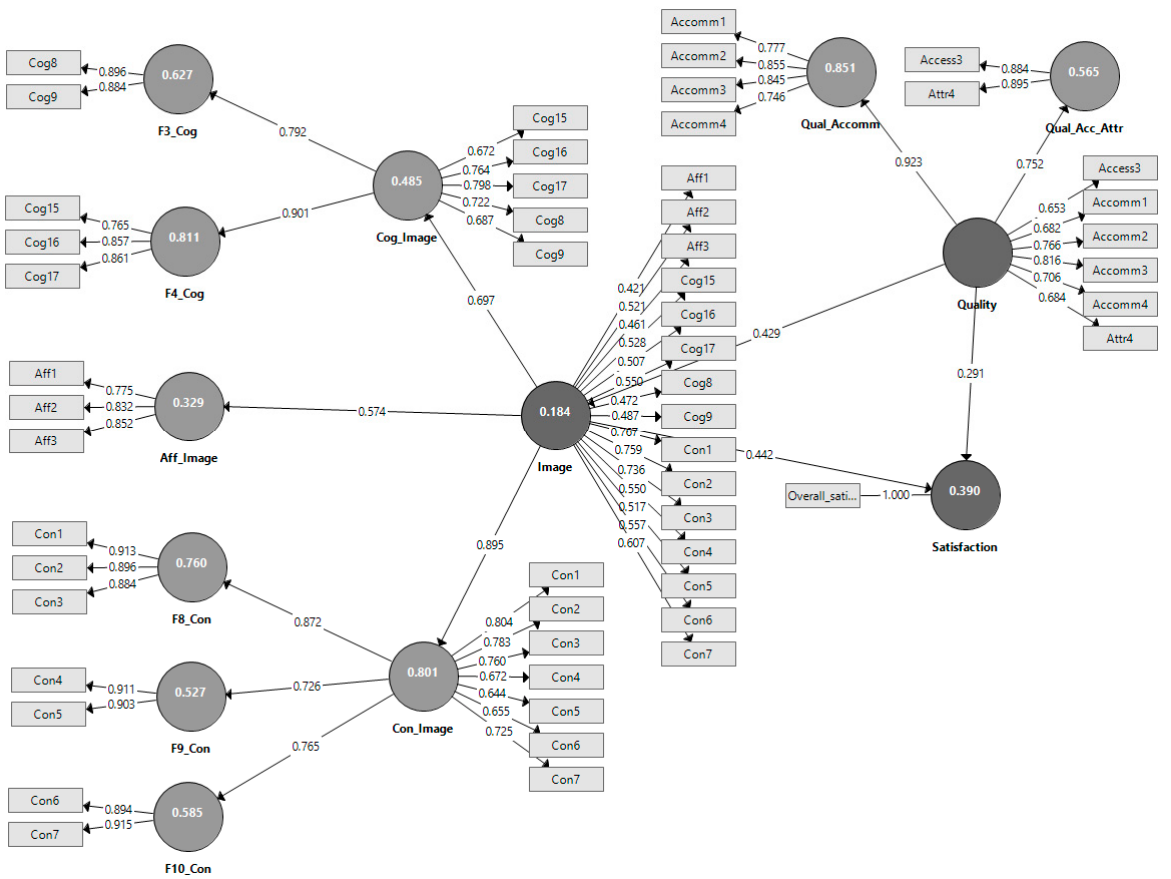
Figure 3. Measurement models with factor loadings, R2 values, and path coefficients.